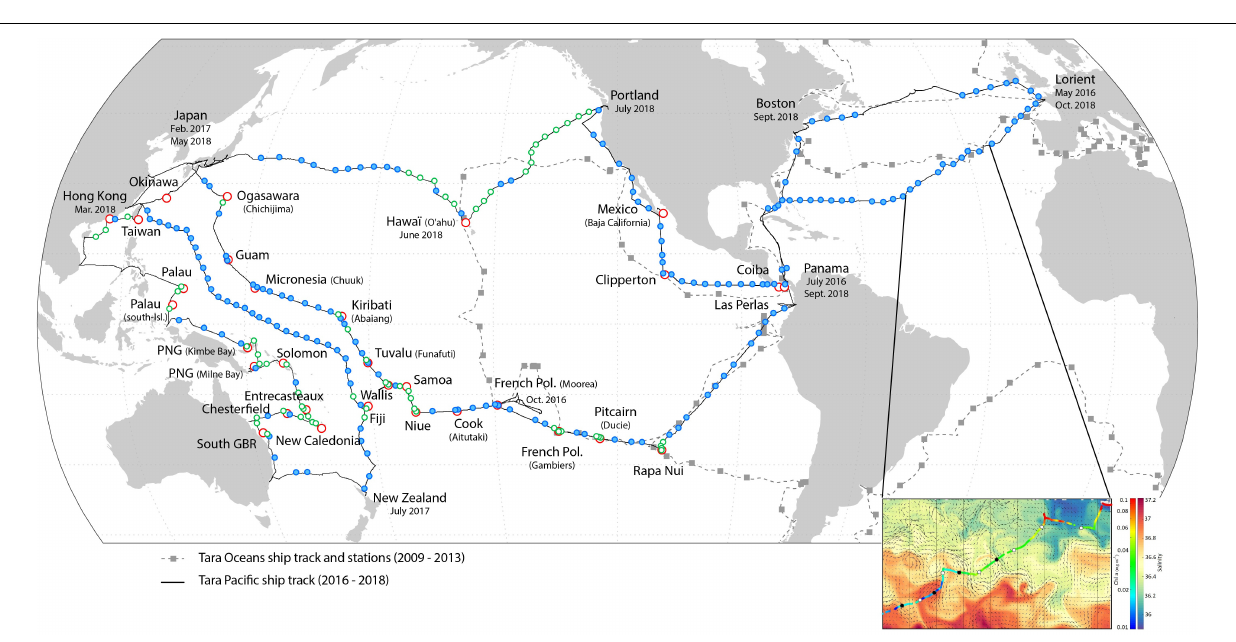
FIGURE 2 | Geographic location of daytime discrete sampling sites (blue symbols). Green symbols indicate sites where the Manta net was also deployed. Red symbols represent the coral islands. For visual clarity, only the daytime sampling sites are shown. In grey: the Tara Oceans expedition’s (2009–2013) sailing track and sampling stations (gray square symbols). Insert: example of mesoscale daytime (white symbols) and nighttime (black symbols) sampling sites. Chlorophyll a concentration (from ACs continuous measurements) is shown along the ship’s track. Salinity and current velocity fields obtained from Copernicus Marine Service prediction models are shown in the